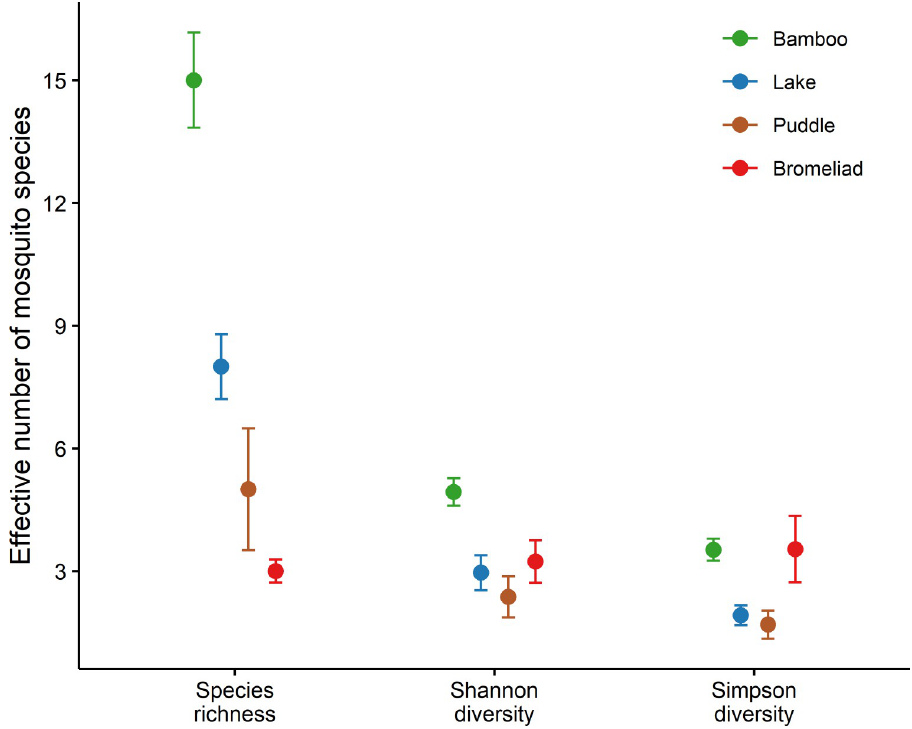
Fig 5. Diversity profile of mosquito assemblages found in four types of breeding sites in a forest fragment at the Poc¸o das Antas Biological Reserve in southeastern Brazil. The graph shows the values of three diversity indices–(i) species richness, (ii) the exponential of Shannon’s entropy index (Shannon diversity), and (iii) the inverse of Simpson’s concentration index (Simpson diversity)–derived from extrapolation curves for 827 individuals (see Fig 4) for each type of breeding site. Error bars represent the 95% confidence